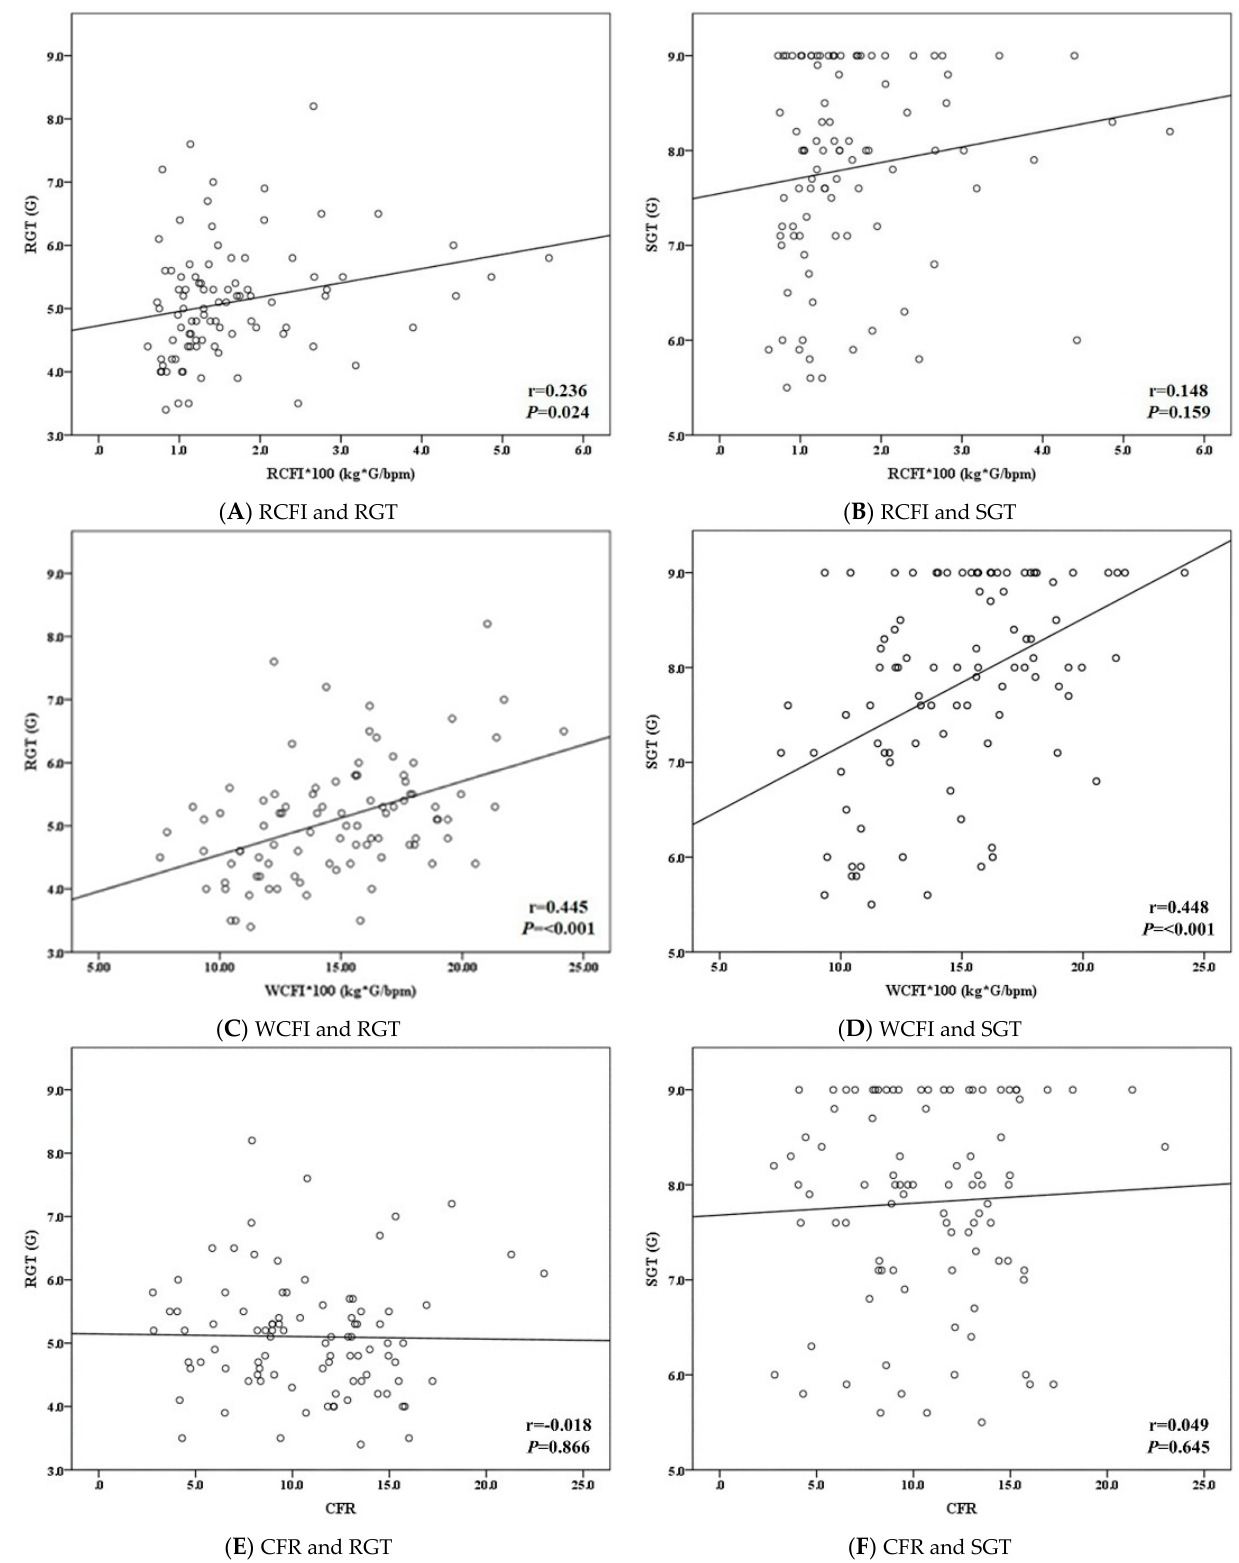
Figure 6. Linear association between the cardiac function and G tolerance. RCFI: resting cardiac force index; WCFI: walking cardiac force index; CFR: cardiac force ratio; RGT: relaxed G tolerance; SGT: straining G tolerance; r: Pearson correlation coefficient.